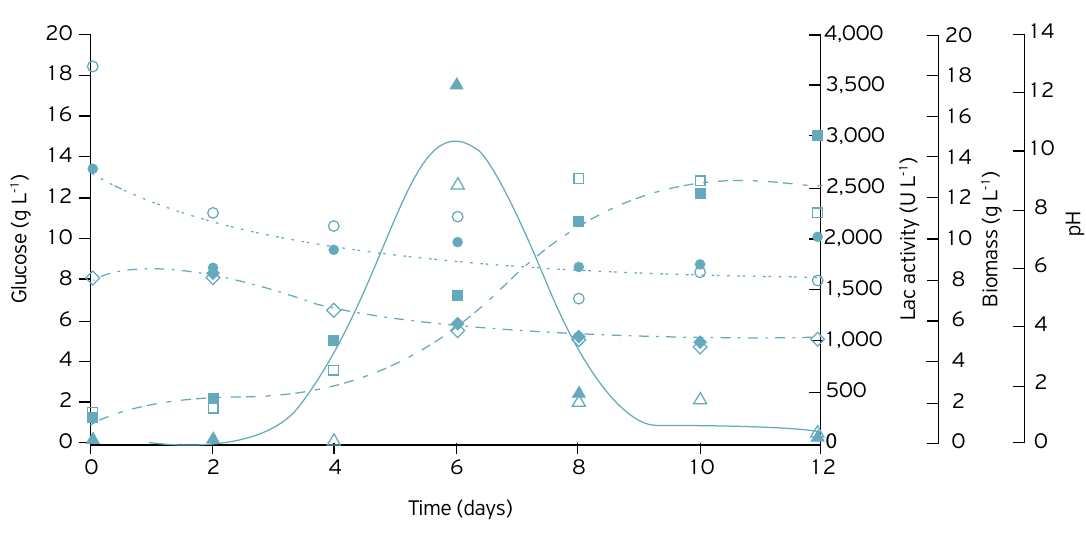
Figure 2. Profiles of biomass growth (dashed line, -  -, -  -), glucose consumption (dotted line, -  -, -  -), laccase activity (continuous line, - -, - -) and pH (dash dot line, - -, - -) with time (days), in the presence of 7.5% Tween 80. The open and closed symbols represent data from